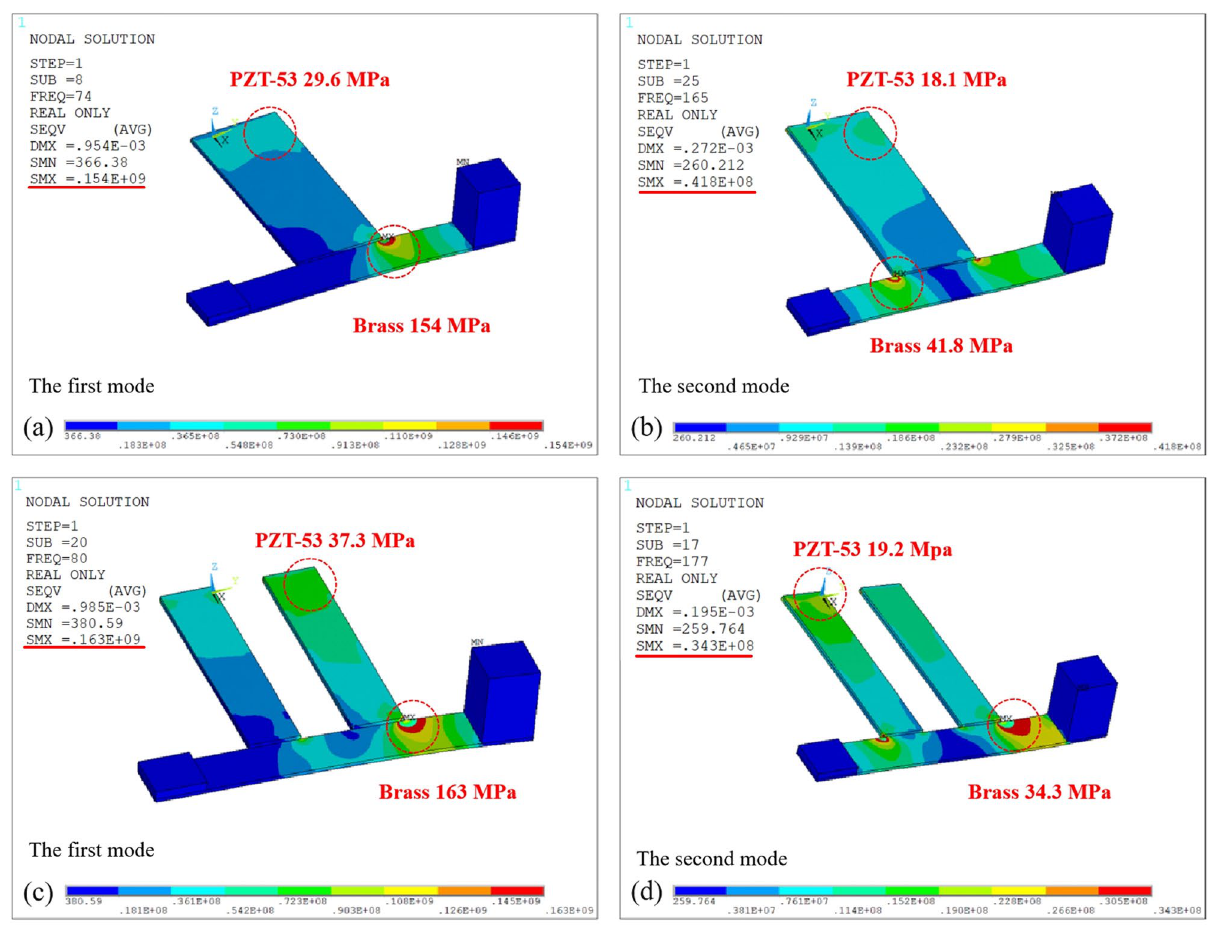
Figure 3. The modal stress diagrams of yield strength ( a,b ) for PEHSCB and ( c , d ) for